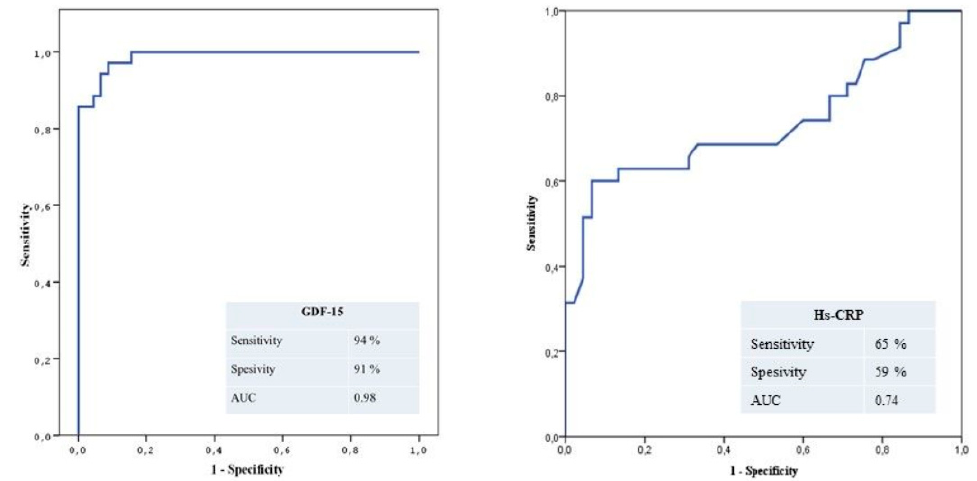
Figure 1. ( A ) The receiver-operating characteristic (ROC) curve of GDF-15 for predicting angiographic no-reflow. ( B ) ROC curve of Hs-CRP for predicting angiographic no-reflow. There was a significant correlation between hs-CRP and GDF-15 (r: 0.6030.56; p < 0.001) (Figure 2). Diseases 2020 , 8 , x FOR PEER REVIEW